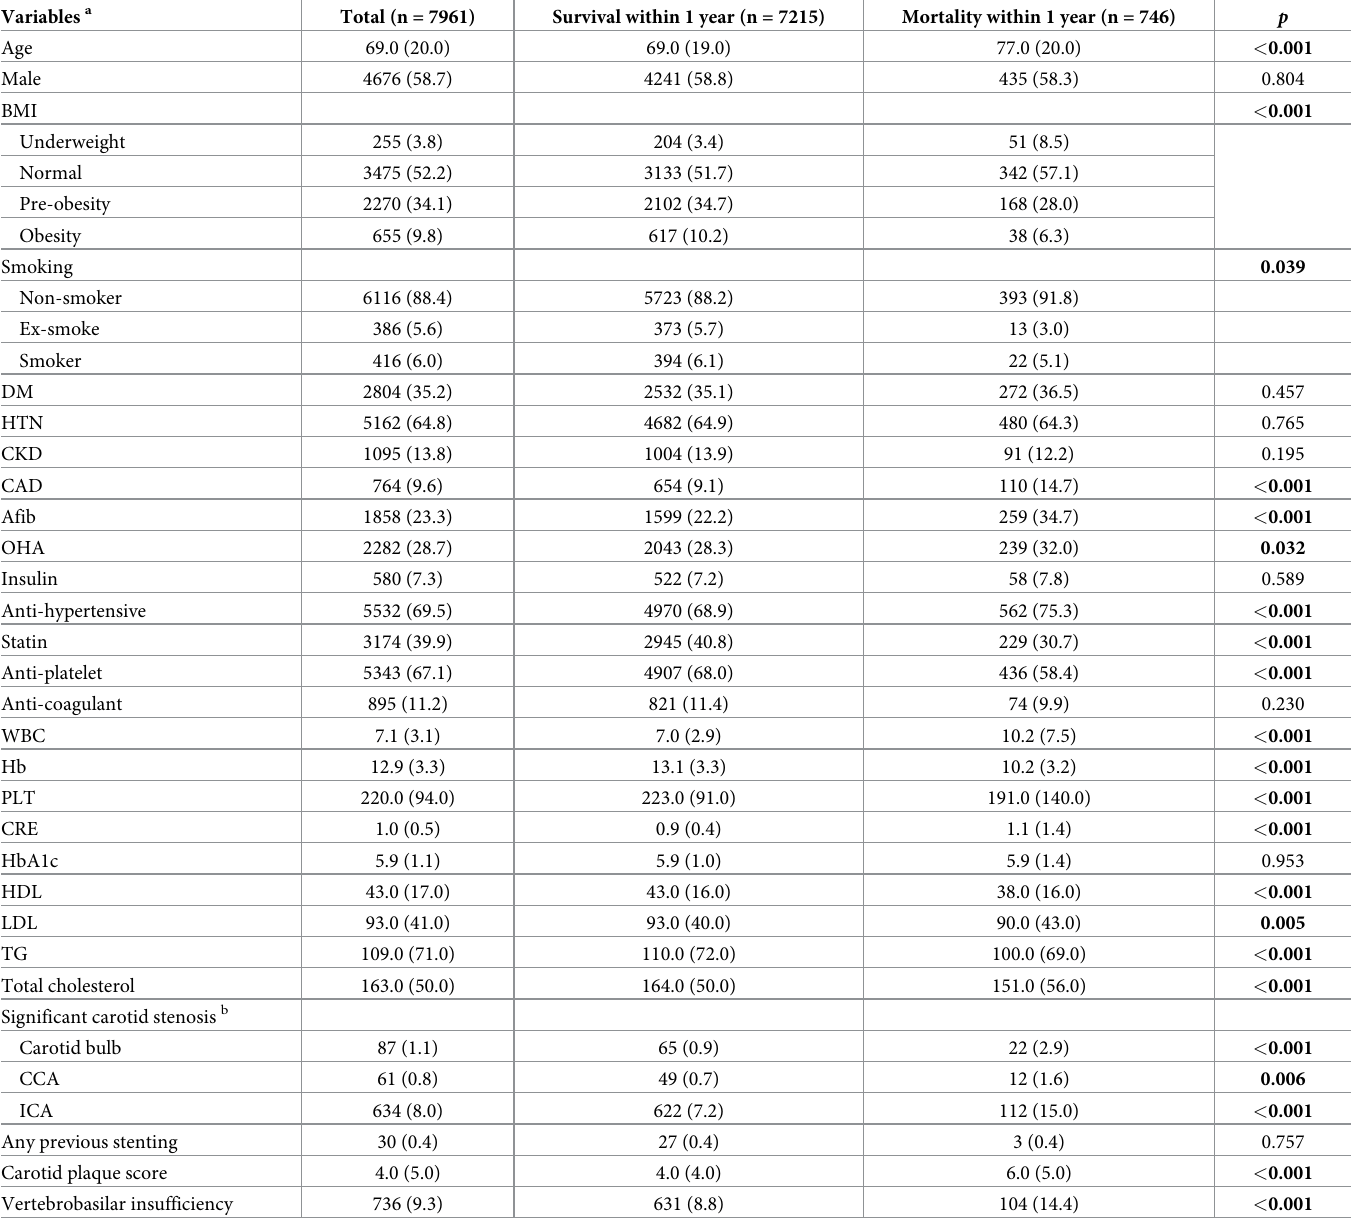
Table 1. Basic characteristics of included